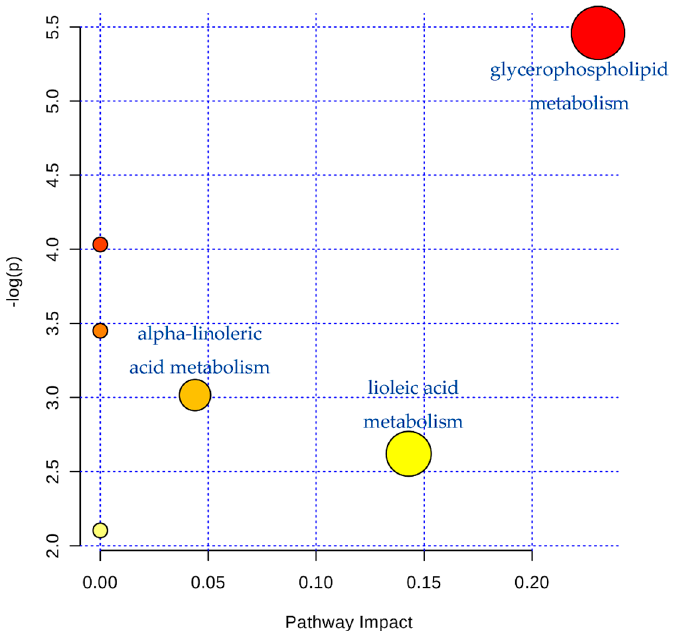
Figure 8. The potential metabolic pathways according to the identified biomarkers by MetaboAnalyst 2.0 analysis. The area of marked circles represents the importance of the metabolic pathway in LPS-induced endotoxic fever rats.